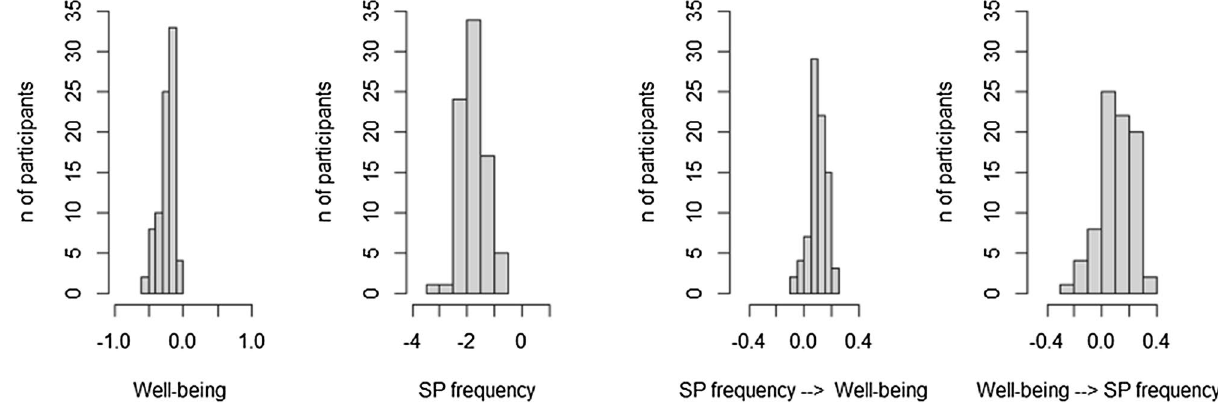
Figure 6. Distribution of individual continuous auto- and cross-effect parameters of the Hierarchical Bayesian Continuous Time Dynamic Model of well-being and frequency of smartphone use.